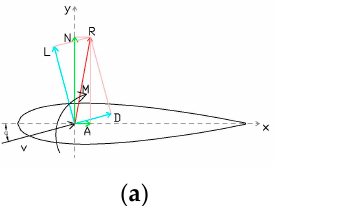
Figure 8. Definition of lift coefficient and moment coefficient in positive and negative directions. ( a ) Forward-blowing, ( b ) reverse blowing. Figure 7. Aerodynamic forces on airfoil surface and their components.